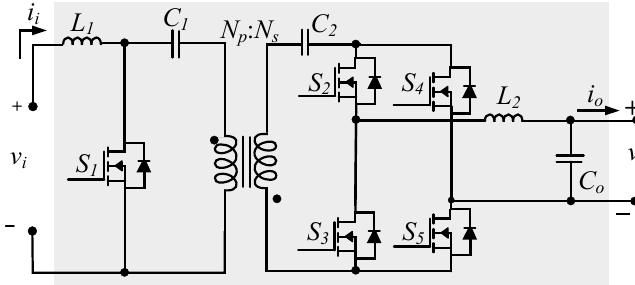
Figure 5. MCI inversion.